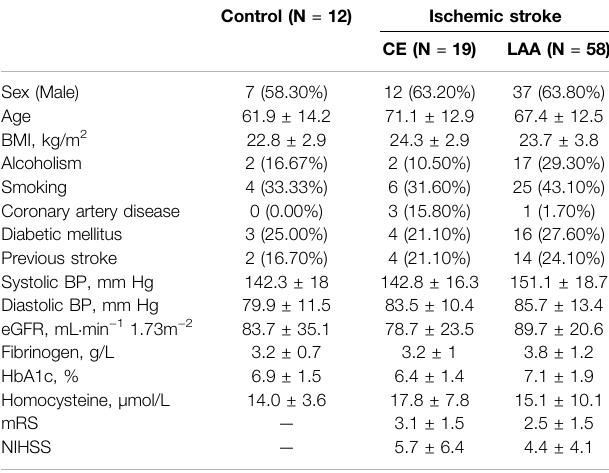
TABLE 1 | Baseline characteristics of the studied subjects. Control (N =